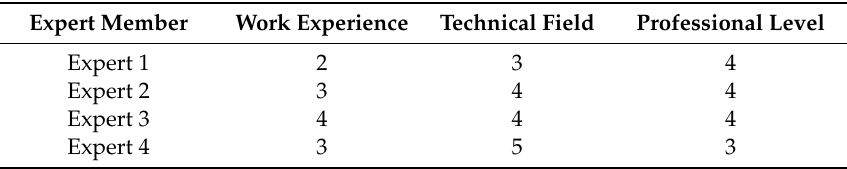
Table 6. Scores of expert members for three performance